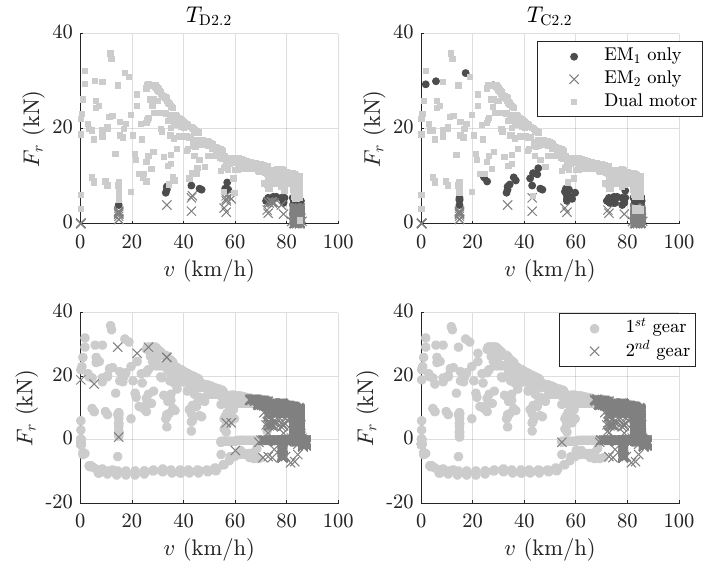
Figure 12. Visualization of the work points of the vehicle over the drive cycle for both T D 2.2 and T C 2.2 . The upper plots indicate the use of the electric machines, where EM 1 only means that only EM 1 supplies power to the wheels and EM 2 only that this is only done by EM 2 . Dual motor indicates that both machines together drive the wheels of the vehicle. The lower two plots indicate the engaged gear for each work point.